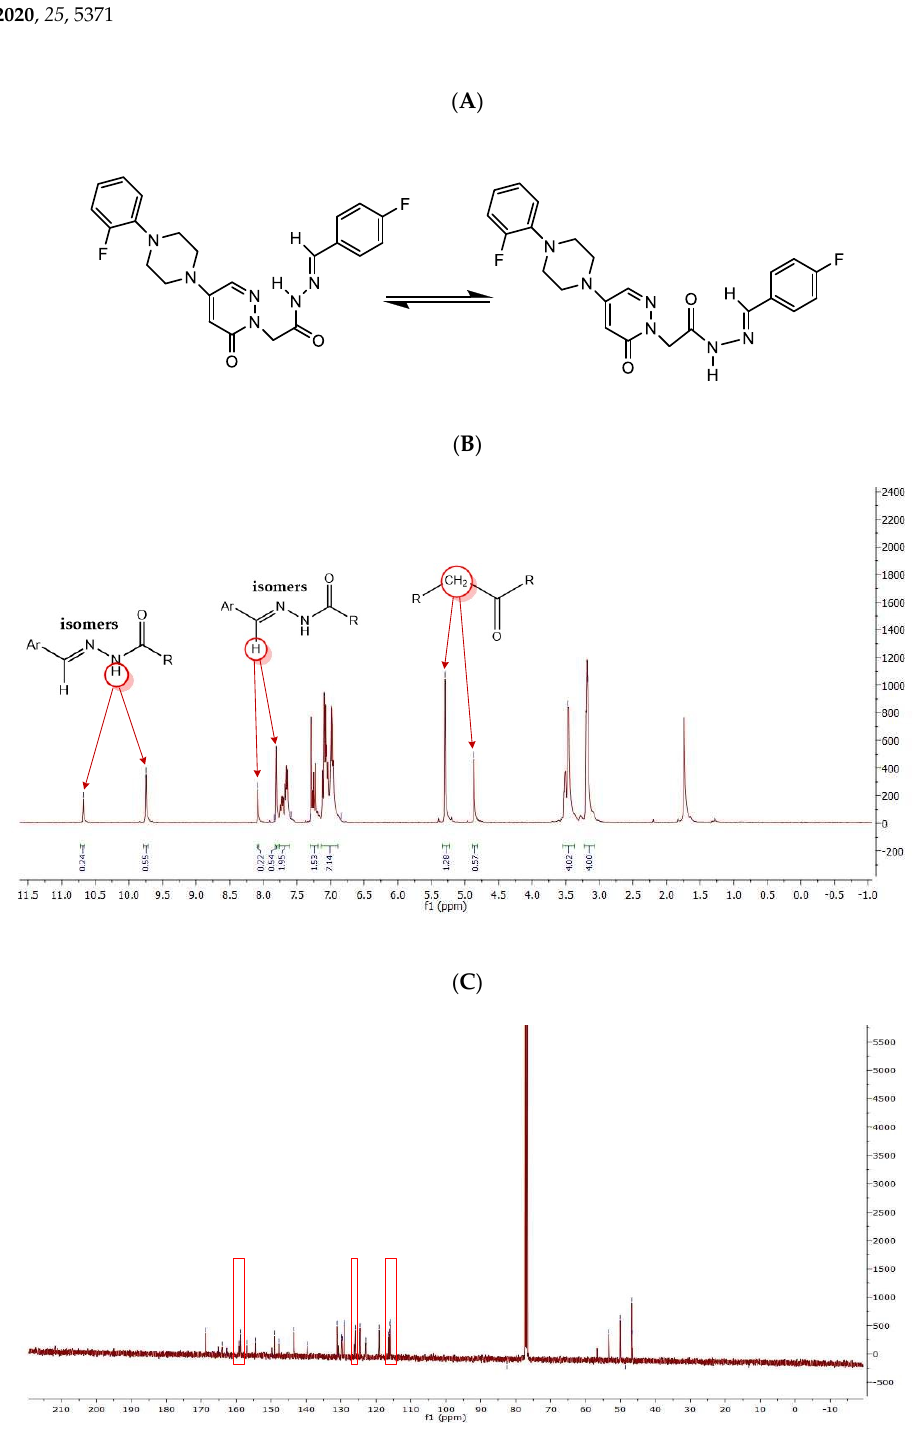
Figure 1. Structures of two conformational isomers ( A ), and 1 H-NMR ( B ) and 13 C-NMR ( C ) spectra of T10 .